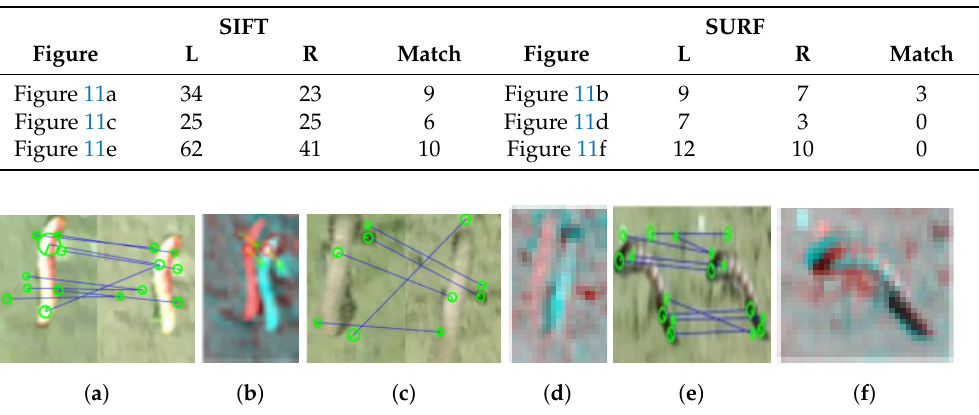
Figure 11. Outcomes of corresponding visual matches of SIFT ( a , c , e ) and SURF ( b , d , f ) are shown in Table 3. Each consists of two stereo camera views of the detected pest with matched features